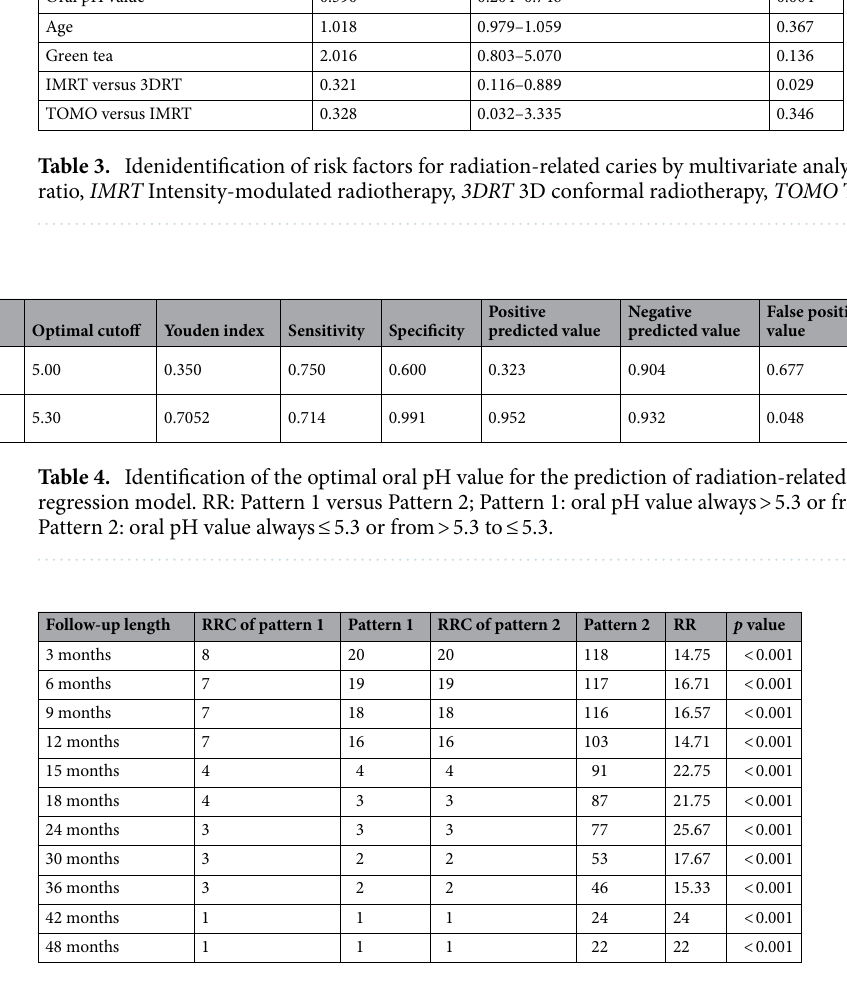
Table 5. Estimation of time-dependent risk ratios for developing radiation-induced caries throughout the follow-up period. RR: Pattern 1 versus Pattern 2; Pattern 1: oral pH value always > 5.3 or from < 5.3 to > 5.3; Pattern 2: oral pH value always ≤ 5.3 or from > 5.3 to ≤